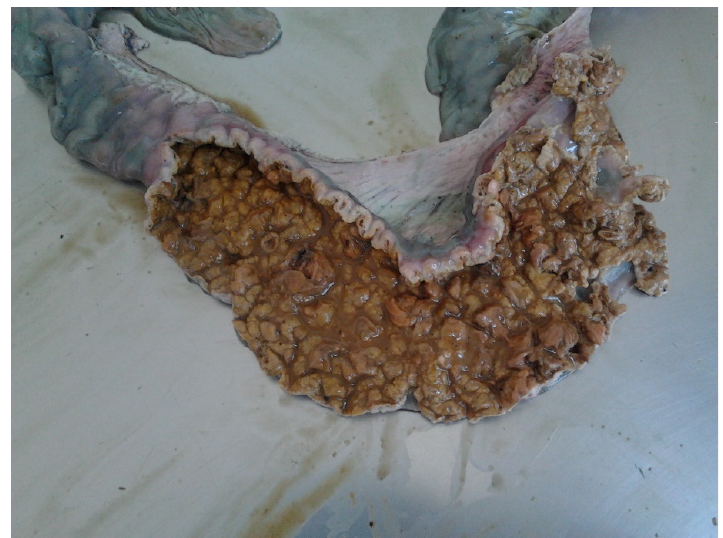
Figure 22. Ileum of pig. The picture shows a PIA complicated by secondary bacterial infections leading to necrotic enteritis, also known as regional ileitis.